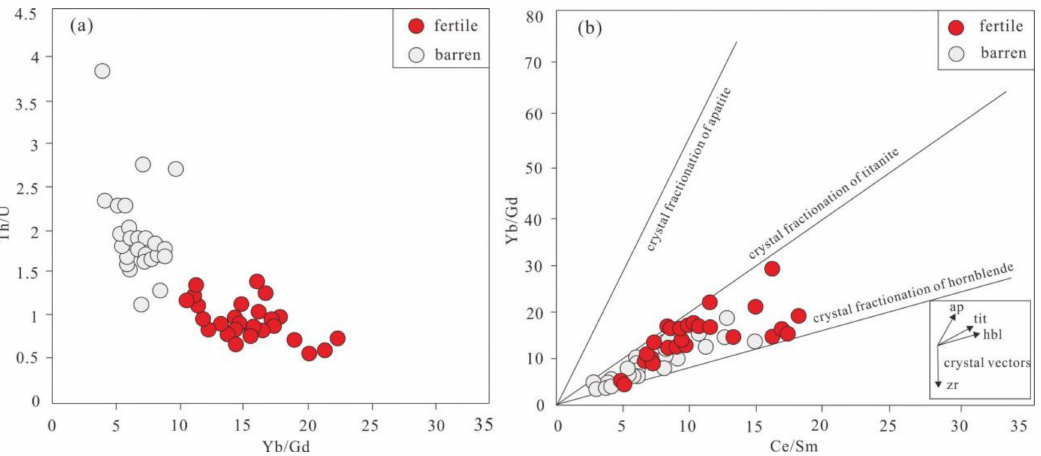
Figure 7. ( a ) Plots of zircon Yb/Gd vs. Th/U diagram, show negative correlation [72]; ( b ) Ce/Sm ratio versus Yb/Gd ratios in zircon [73]. The crystal vector in ( b ) showed the crystal fractionation of apatite (ap), titanite (tit), hornblendes (hbl), and zircon